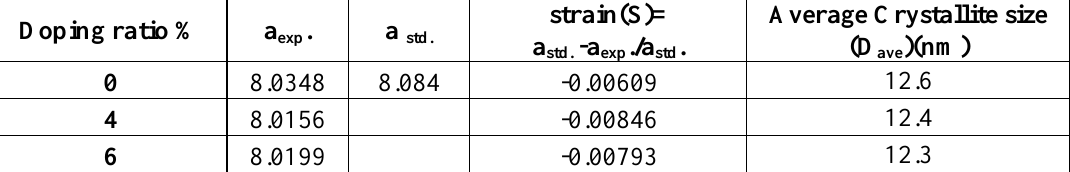
O films and doped with Y. 3 4